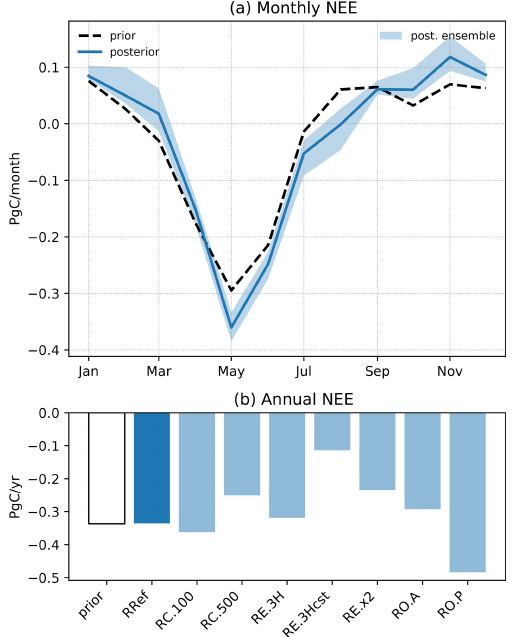
Figure 8. (a) Monthly prior (dashed black line) and posterior NEE (solid line: RRef; shaded blue area: ensemble spread); (b) annual NEE for the prior LPJ-GUESS and the seven inversion